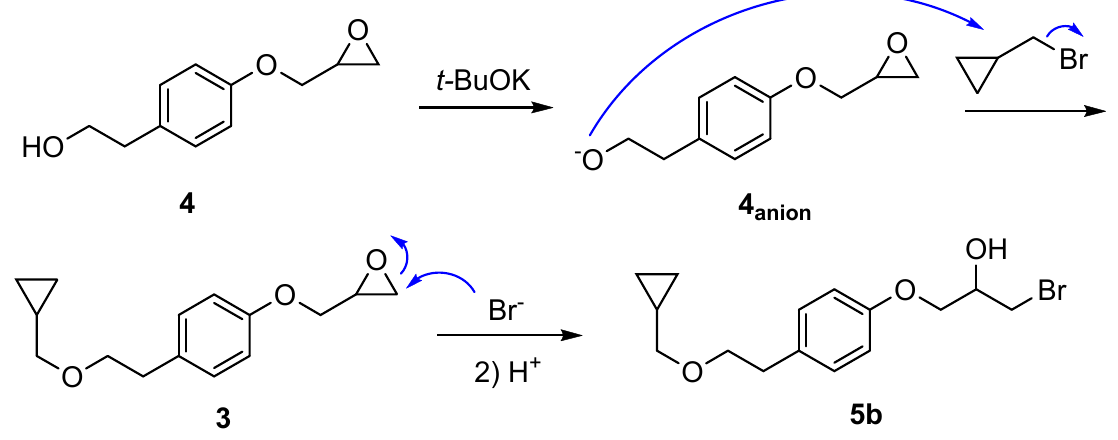
Scheme 3. Suggested mechanism for formation of bromohydrin 5b via a nucleophilic attack of the bromide ion on epoxide 3 .